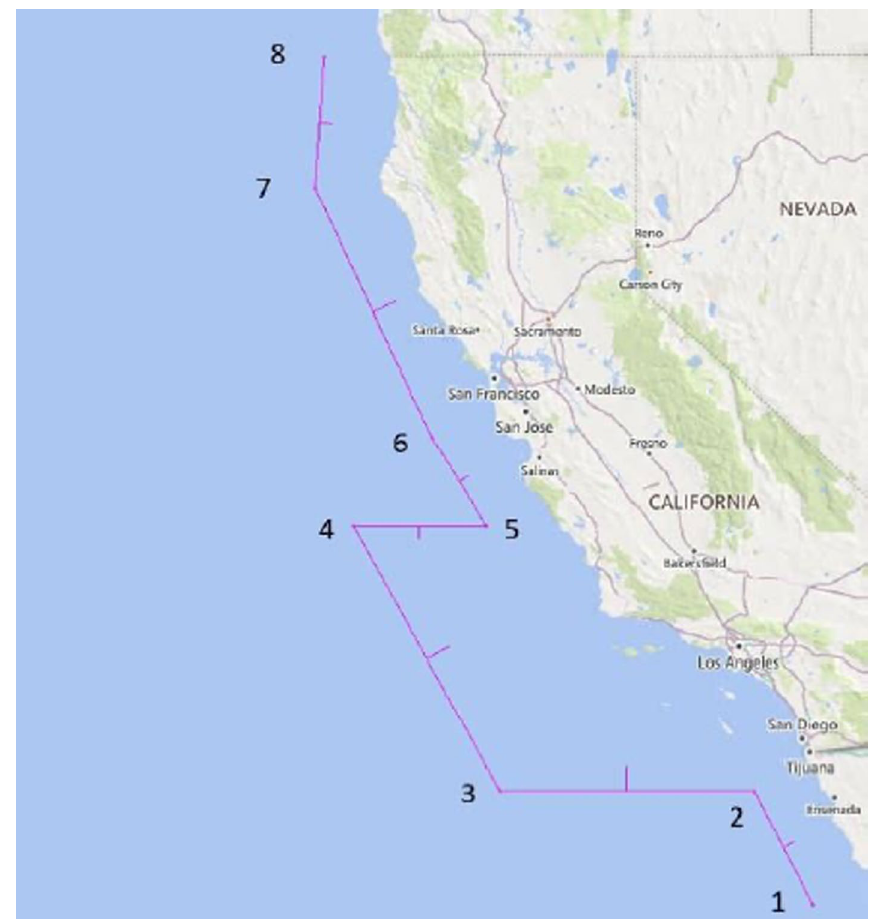
Fig. 3 Safety and Air Quality Area (SAQA). Source : MXSOCAL